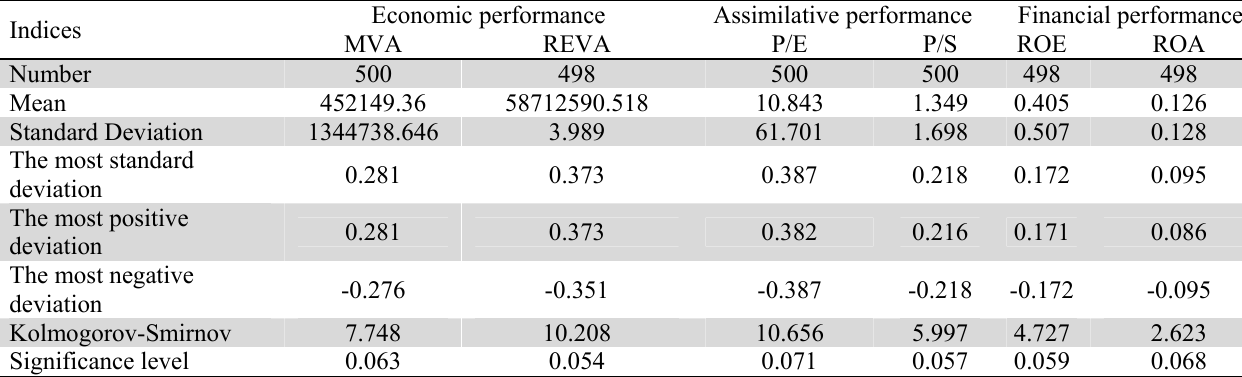
The summary of Kolmogorov-Smirnov test Indices